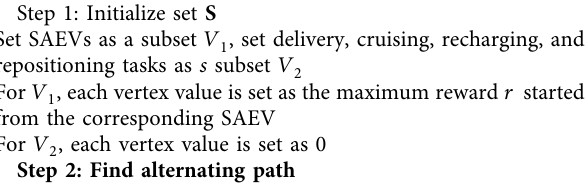
Table 3: Flowchart of the KM algorithm. Step 1: Initialize set S , set delivery, cruising, recharging, and Set SAEVs as a subset V 1 repositioning tasks as s subset V